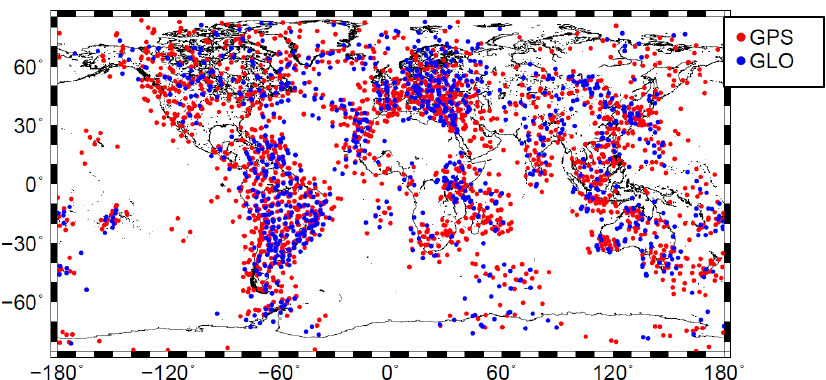
Figure 4. Observation distribution of GPS and GLONASS observations on 17 March 2015 at 12:00 UT, from the global data set D 1